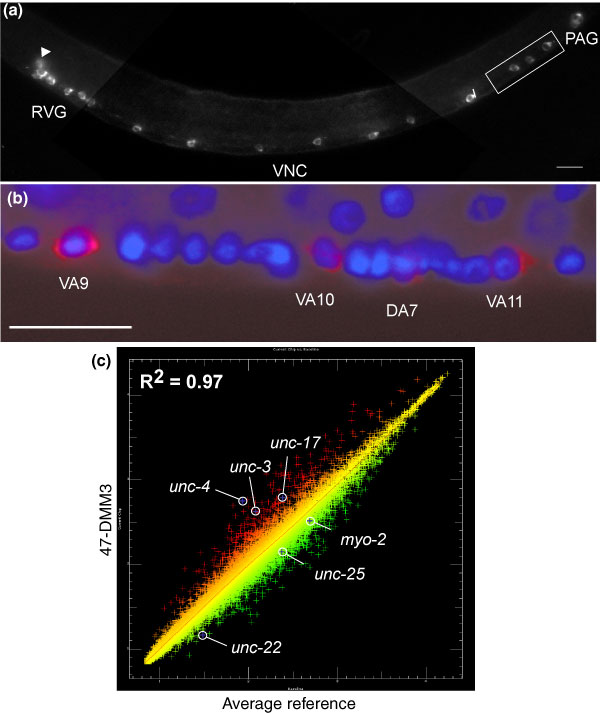
Larval A-motor neuron enriched transcripts are revealed by mRNAtagging with unc-4::3XFLAG::PAB-1. (a) Antibody staining detects FLAG::PAB-1 expression in A-class neurons in the retrovesicular ganglion (RVG), ventral nerve cord (VNC), and pre-anal ganglion (PAG) and in the I5 pharyngeal neuron (arrowhead). Lateral view of L2 larva, anterior is to left, ventral down. (b) Close-up of posterior ventral nerve cord (boxed area in (a)) showing that anti-FLAG staining (red) is restricted to cytoplasm of A-class motor neurons. DAPI (blue) marks cell nuclei (compare to Figure 1, in which all motor neurons show anti-FLAG staining). Anterior is left, ventral is down. Scale bars = 10 μm. (c) Results of a single larval A-class hybridization (47-DMM3; red) compared to average reference intensities (green) to identify differentially expressed transcripts. The known A-class genes unc-4 (homeodomain, A-class neurons), unc-3 (O/E transcription factor, cholinergic VNC motor neurons), and unc-17 (VAChT, cholinergic neurons) are enriched (red) in 47-DMM3. Genes expressed in other classes of neurons (unc-25, GAD, GABAergic neurons) or other tissues (myo-2, pharyngeal muscle myosin; unc-22, body wall muscle structural protein) are depleted (green) relative to the reference profile.